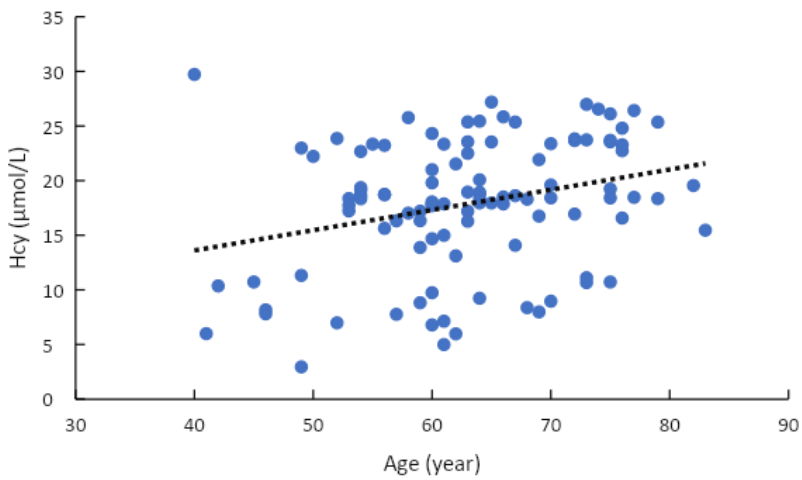
Figure 3. Plasma total homocysteine concentration and age correlation.